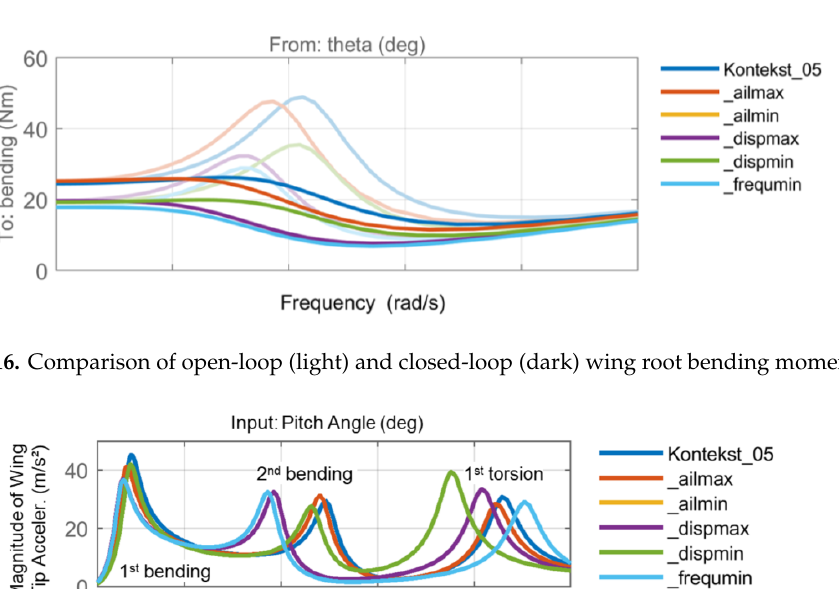
Figure 15. Comparison of the achieved wing root bending moment (WRBM) reduction at a true airspeed of 40 m/s evaluated in terms of the expected variance for a white noise gust excitation simulated by pitching the wing.